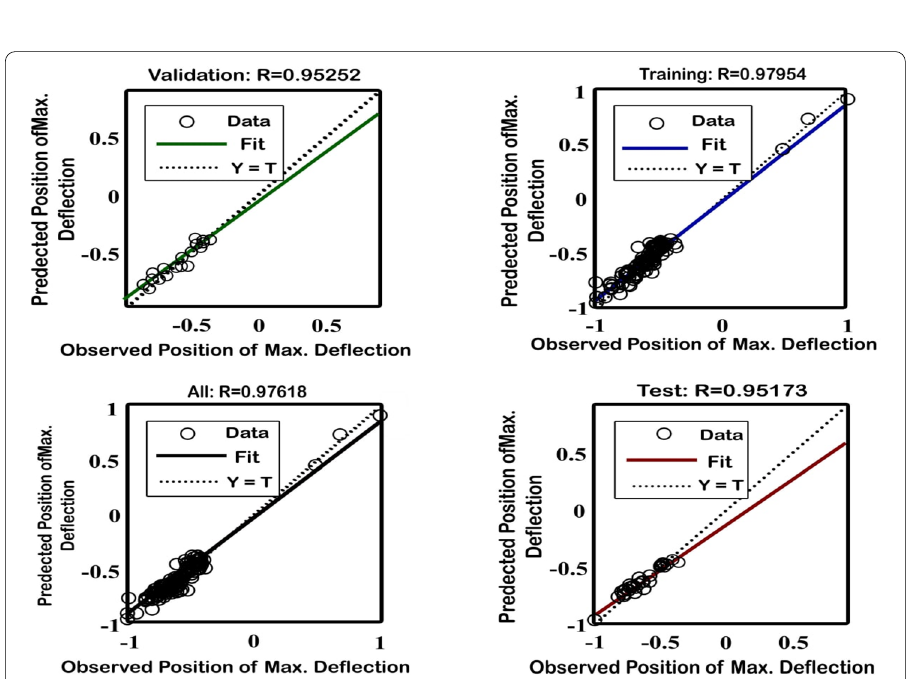
Fig. 7 Comparison between Predicted and Observed position of max. deflection δ H for All data set, Training data Set, Testing Data Set, and Validation Data